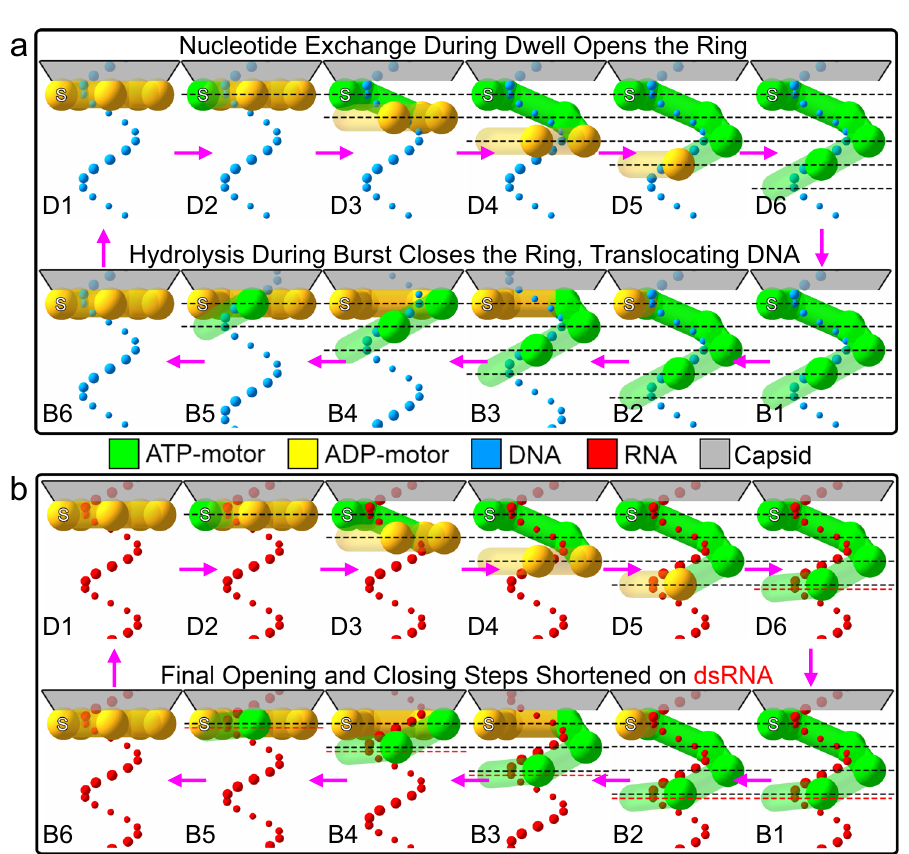
Fig. 4 Translocation mechanism for the ϕ 29 DNA-packaging motor. The mechanism of the motor packaging ( a ) dsDNA and ( b ) dsRNA is shown. For each state, the ring ATPase complex is presented from the side, with each subunit represented as a cylinder with a sphere at its hinge and colored by nucleotide state. The capsid is above in gray and the special subunit is on the left, marked with an S. Tracking strand phosphates are depicted as colored spheres. The states in the dwell are labeled as D1 – D6 and the states in the burst are labeled B1 – B6. D6 and B1 are the same state, as well as D1 and B6, repeated only for horizontal comparison. Dashed lines with spacing 0.85 nm show the extent of ring opening. One phosphate is colored magenta during the burst to track translocation. During the dwell, ADP exchanges for ATP, which opens the ring. During the burst, ATP hydrolysis drives DNA translocation. It is noteworthy that the fi rst exchange and hydrolysis is in the special subunit, which causes no ring opening or substrate translocation. On dsRNA, the mechanism is identical, except for the fi nal opening and closing steps, which are shorter and are denoted by the red dashed lines. See also Supplementary Movie 1 and